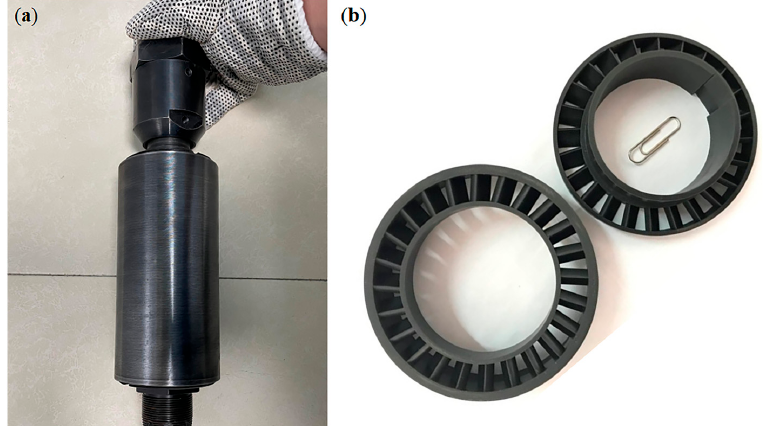
Figure 12. DFDR model machine parts manufacture and assembly. ( a ) A DFDR model machine in the assembling process; ( b ) the manufactured turbine stage.